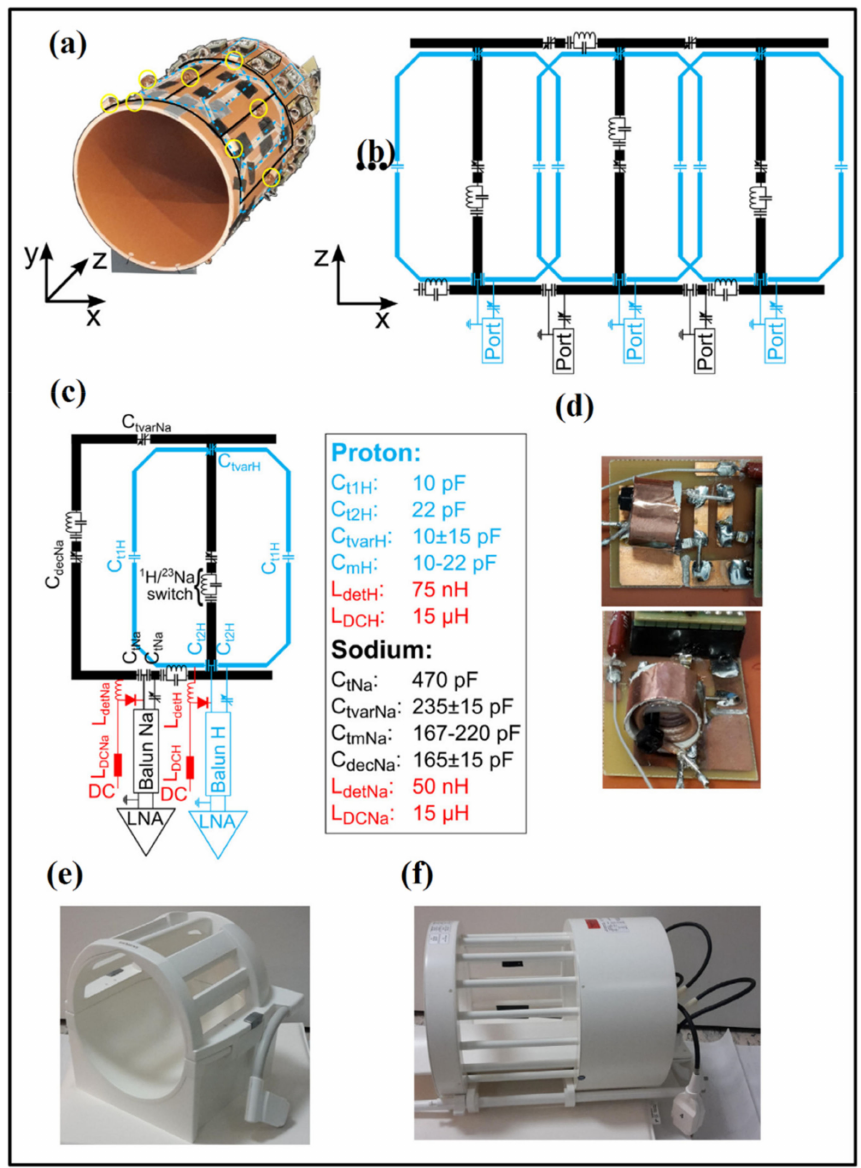
Figure 15. ( a ) Image of the 8Rx hydrogen/8Rx sodium coil, where the sodium coil is highlighted with the solid black lines and the hydrogen coil with the dotted blue lines; ( b ) part of the coil circuit with two sodium elements (in black) and three hydrogen elements (in blue); ( c ) sketch of a single sodium (black) and a single hydrogen (blue) coil element; ( d ) cable trap in a top and a front view; ( e ) Image of the commercial 12Rx coil; ( f ) image of the commercial TxRx hydrogen/sodium coil. Reprinted by permission from Malzacher et al., Magn Reson Imag 2019